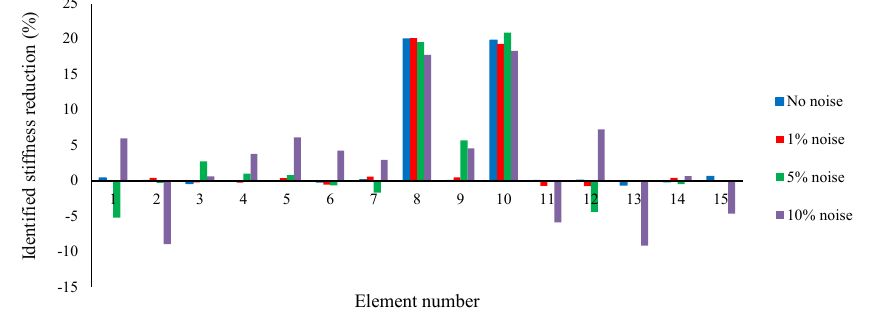
Figure 8. Effect of noise on damage identification at speed 40 m/s. Table 8. Identification results at different noise levels and vehicle speed- road roughness A.